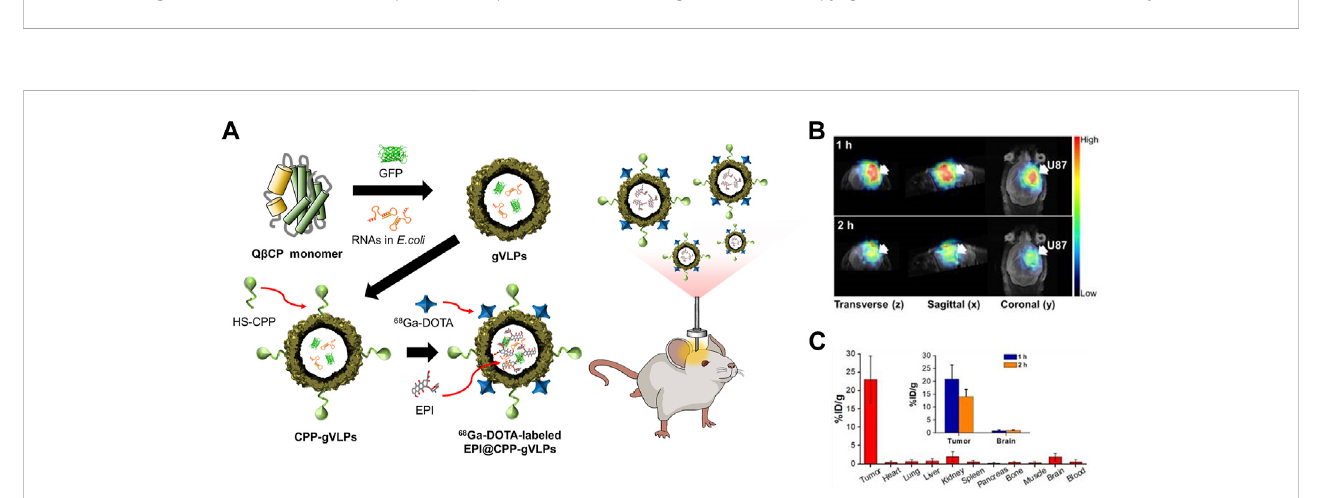
FIGURE 5 (A) Schematic diagram of the preparation of 68 Ga-DOTA labeled EPI@CPP-gVLPs for bio-imaging brain tumors. (B) Representative micro-PET-MR images of U87-MGLu brain tumor mice using 68 Ga-DOTA labeled EPI@CPP-gVLPs. (C) The organ distribution of 68 Ga-DOTA labeled EPI@CPP-gVLPs (Pang et al.,